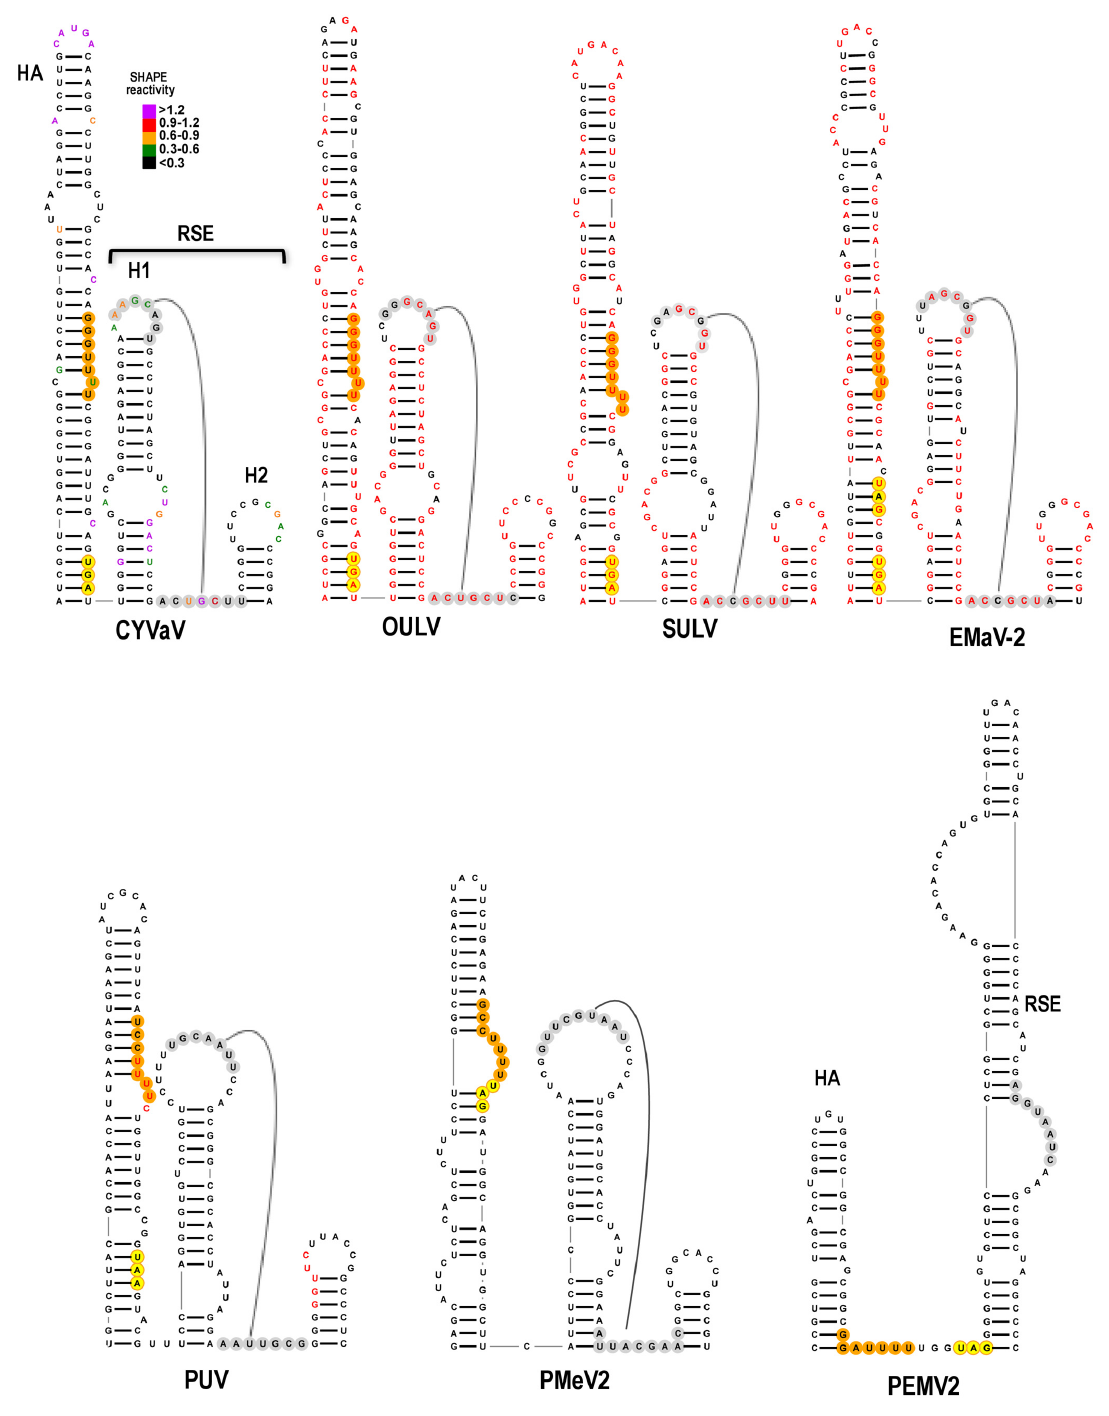
Figure 6. Structures at the -1PRF site in ulaRNAs and umbravirus PEMV2. One of two conformations possible at the recoding site of the ulaRNAs (see Figure 7 for the alternative structure). SHAPE data is presented on the CYVaV structure whereas red residues in the other structures denote sequence conservation with CYVaV. Hairpin A (HA) is a hairpin just upstream from the recoding site, and a hairpin at this location relative to the ribosome recoding site is conserved for all viruses in the Tombusviridae examined. For all Class 2 ulaRNAs with the exception of EMaV, HA contains the slippery site (shaded orange) and ORF1 termination codon (shaded yellow) in identical locations. Note that EMaV has a new upstream in-frame termination codon. Proposed conserved pseudoknots are shown, which would negate the ability of the H1residues to participate in the long-distance interaction with complementary sequence at the 3 (cid:48) end. See Supplementary Materials Figure S2 for SbaVA and BabVQ